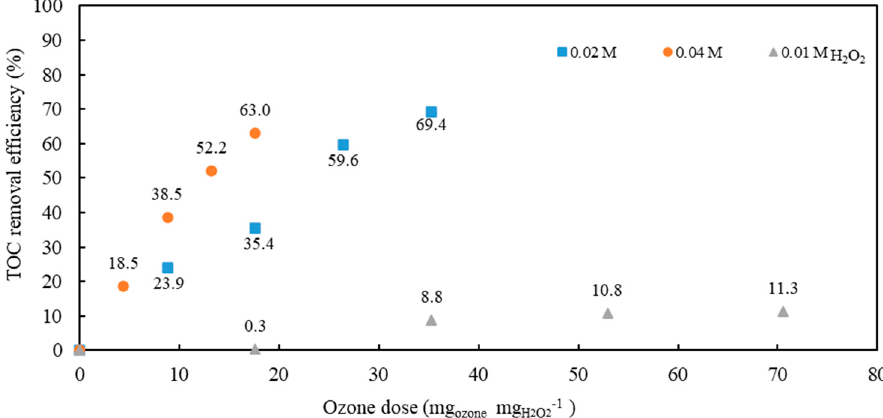
Figure 3. Comparison of different concentrations of ozone for ozonation of model wastewater containing AMX and CIP.